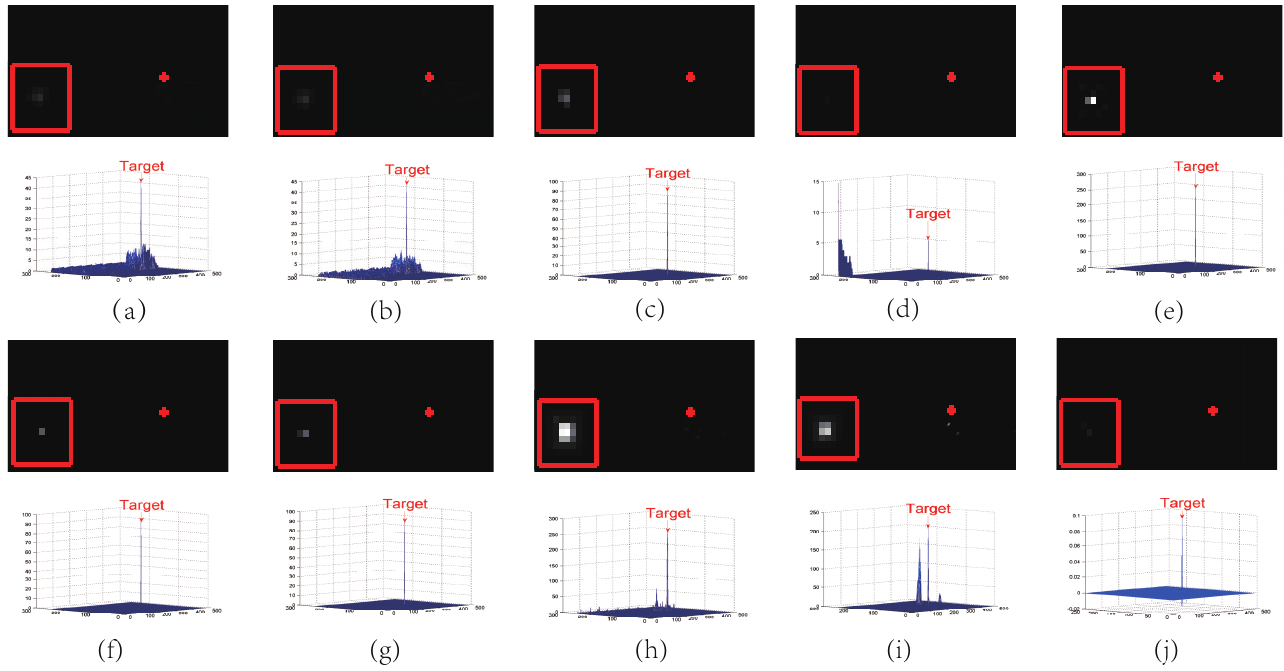
Figure 8. ( a – j ): Top hat, ANI, PSTNN, ASTTV, GST, NTFRA, NRAM, HB-MLCM, ADMD, and the proposed method’s difference diagram and three-dimensional diagram in scene D,